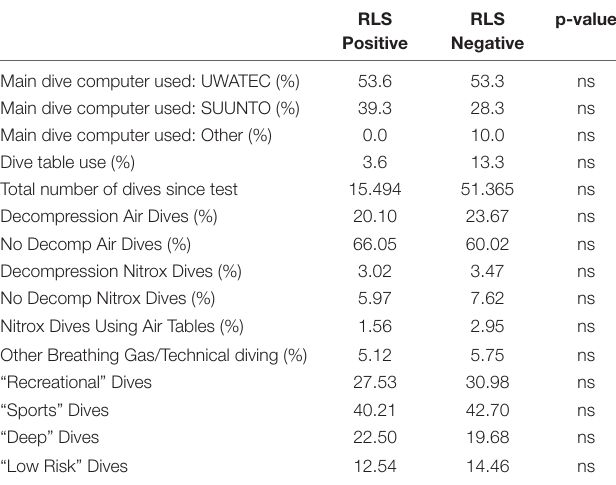
TABLE 2 | Type of diving performed during study period (for description of types of dives, see article text).